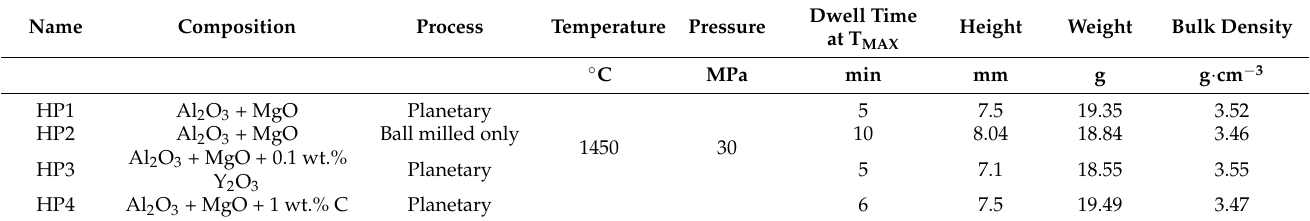
Table 1. Starting composition, sintering parameters,